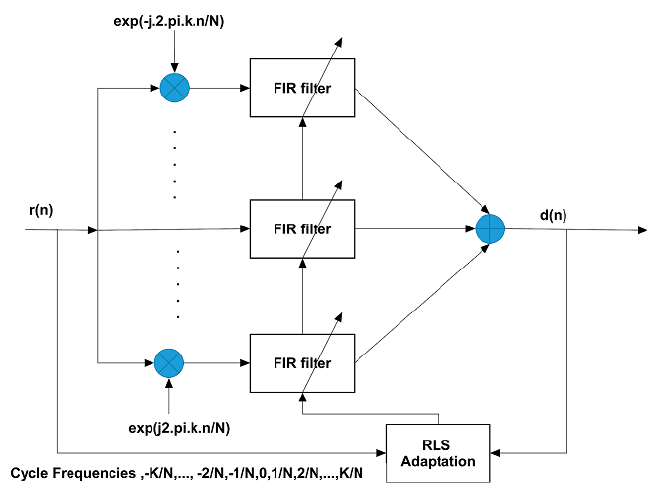
Figure 1. Basic Block Diagram of RLS based BA-LCL-FRESH Filter.